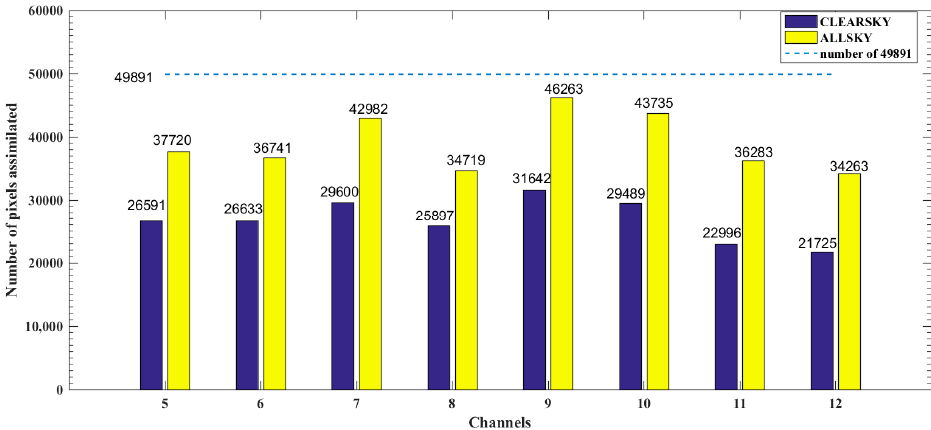
Figure 3. The numbers of pixels assimilated under clear-sky (blue) and all-sky (yellow) condition. The dash line represents the number of 49891.